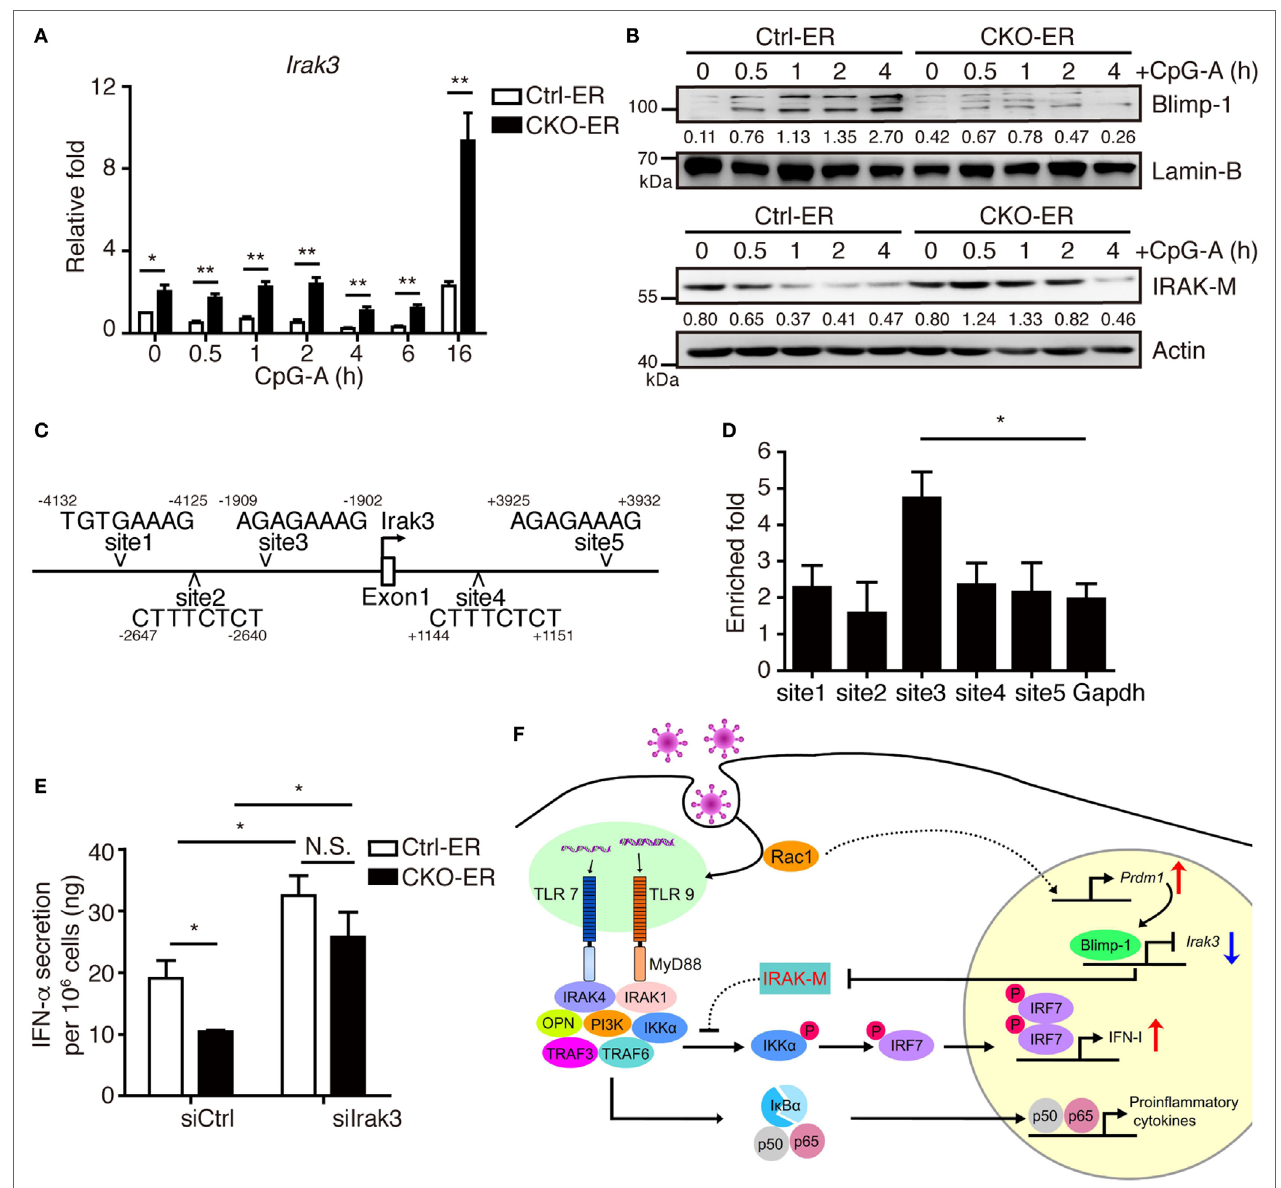
FigUre 8 | Increased IRAK-M expression in pDCs lacking Blimp-1 contributes to impaired IFN-I production. (a,B) RT-qPCR showing Irak3 mRNA levels (a) , IRAK-M and Blimp-1 protein levels (B) in Ctrl-ER and CKO-ER FLpDCs treated with 4-OHT and then stimulated with 1 µM CpG-A. The quantitation of Blimp-1 in (B) was presented by the ratios of Blimp-1 band intensity vs. Lamin-B band intensity at each time point. The quantitation of IRAK-M in (B) was presented by the ratios of IRAK-M band intensity vs. actin band intensity at each time point. (c) Five putative Blimp-1 consensus binding sites were identified within 5 kb upstream and downstream of the Irak3 transcriptional start site (TSS, indicated by an arrow). (D) ChIP assay using chromatin isolated from FLpDCs following 4 h stimulation with 1 µM CpG-A showing the levels of binding of Blimp-1 at various putative sites. Gapdh was used as the negative control locus. (e) IFN- α production